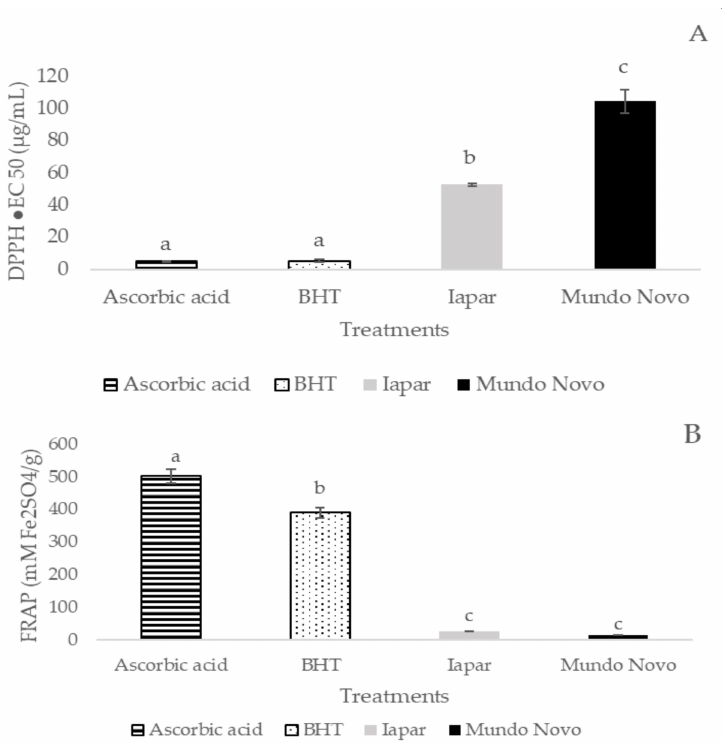
Figure 1. Antioxidant activities of the Iapar-59 and Mundo Novo 376/4 cultivars and the standards (ascorbic acid and butylated hydroxytoluene: BHT) by the methods of free radical scavenging activity: DPPH ( µ g/mL) ( A ), and ferric reducing antioxidant power: FRAP (mM Fe 2 SO 4 /g) ( B ). Bars followed by the same lowercase letter do not differ statistically by Tukey test ( p < 0.05) (n = 6 biological replicates).